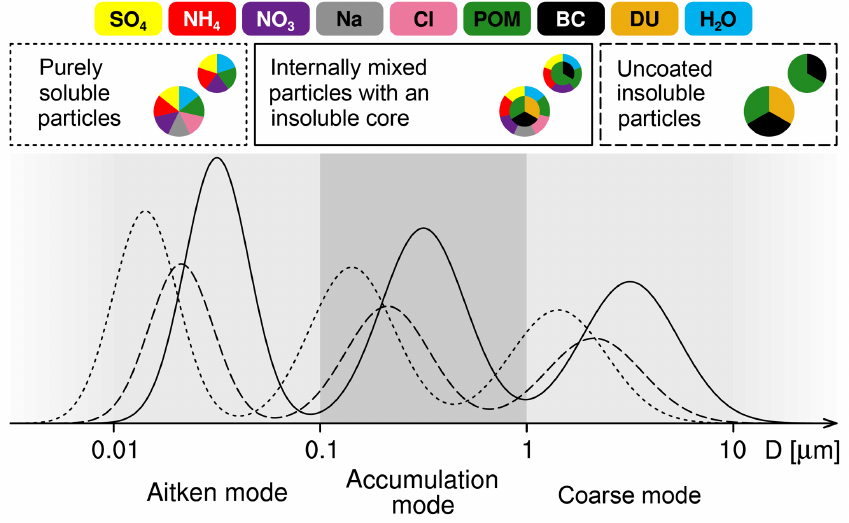
Figure 1. Schematic representation of the MADE3 submodel. The colors represent the different chemical components. The dotted, solid, and dashed lines correspond to the different mixing states (soluble, mixed, and insoluble,